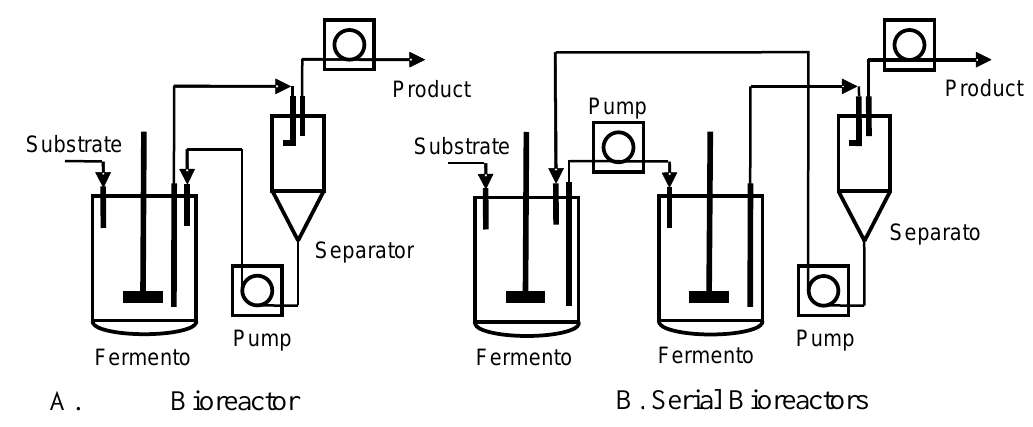
Figure 1 . Schematic diagram of fermentation systems with recycling flocculating yeast in (A) a single bioreactor, (B) two bioreactors in